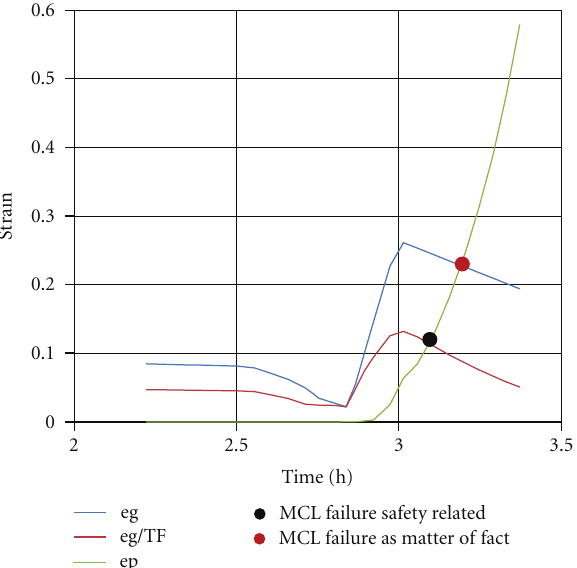
Figure 18: Structure mechanic assessment for a typical integration point in the surge line (eg: strain at uniform elongation concerning the respective temperature, eg/TF: strain at uniform elongation divided by stress triaxiality factor, ep: calculated accumulated plastic